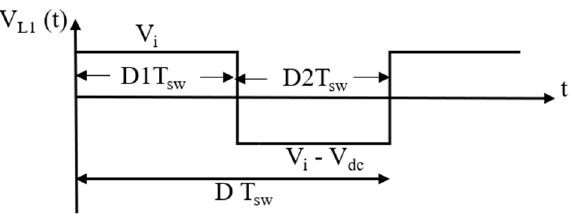
Figure 6. Switching signals applied to gate terminals, M3 and M4.